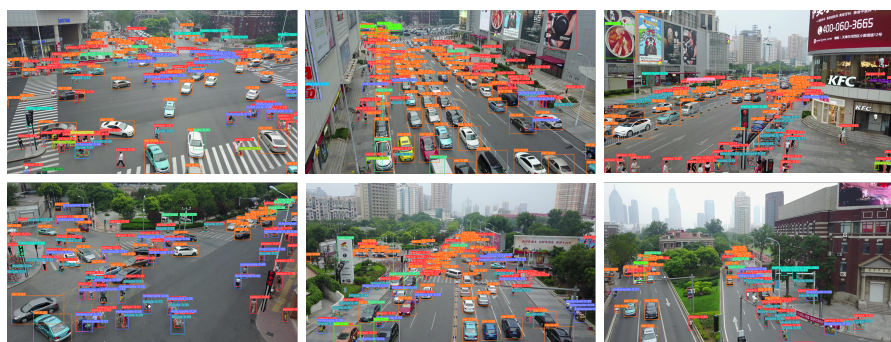
Figure 11. Visualization results on